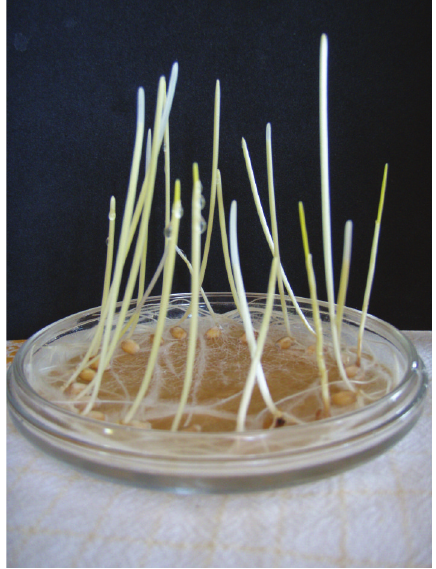
FIGURE 3: Example of stalk growth, from